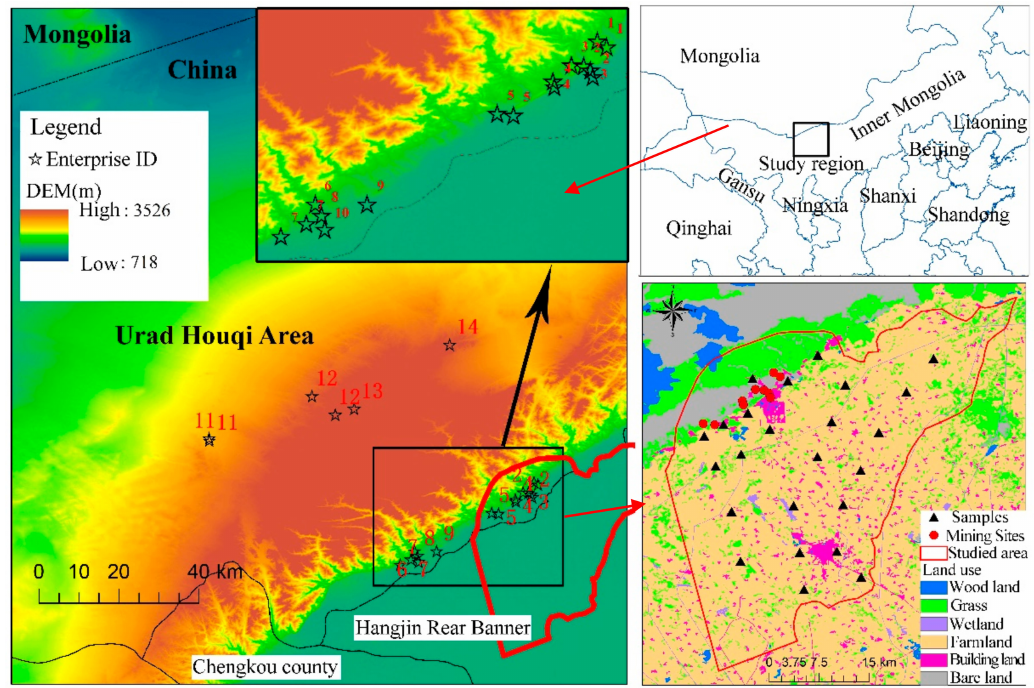
Figure 1. Location of different mining enterprises and sampling